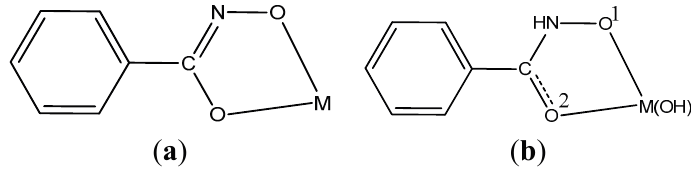
Figure 8. Binding models of BHA with metal ion ( a ) and metal hydroxyl ion ( b ).